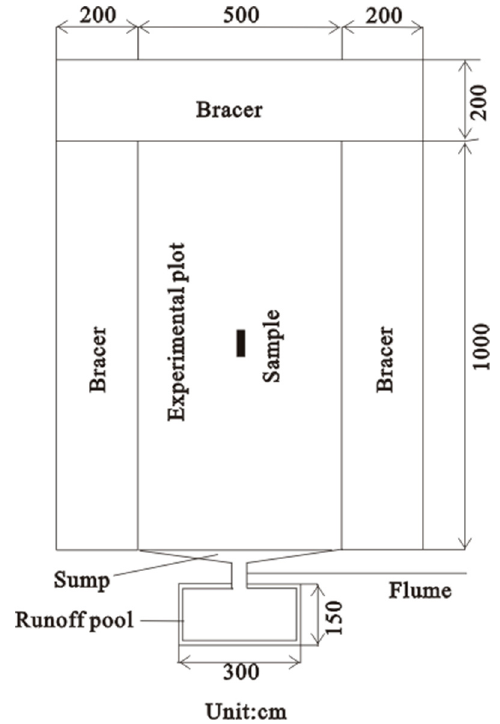
Figure 2. A diagram of the experimental plot.